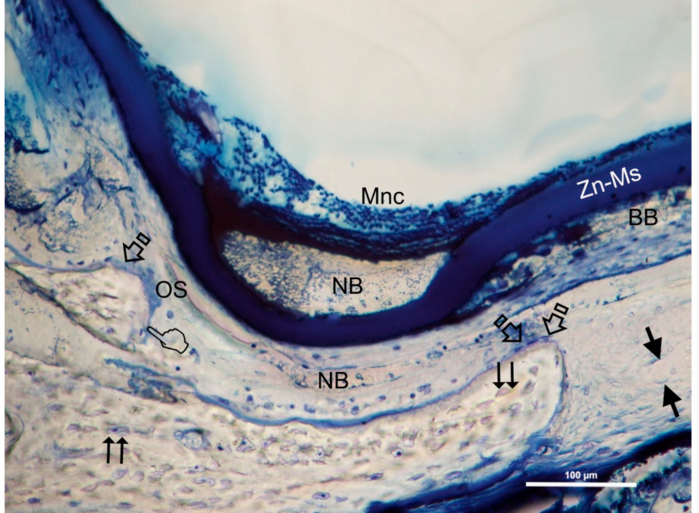
Figure 5. Bone histology image obtained by dye with toluidine blue after using Zn-NMs, in ex- perimental animals after their healing time. Few isles of newly formed trabecular bone (NB) were observed at both side of Zn-NMs. Single arrows point the presence of osteoblasts; double arrows mean osteocytes and pointers indicate osteoclast. Face arrows mean blood vessels. Bony bridging (BB), mononuclear cells (Mnc) and osteoid (Os) may be observed.